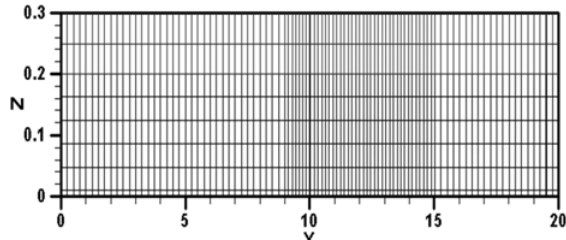
Fig.8 Grid system around vertical groyne on flat bed in